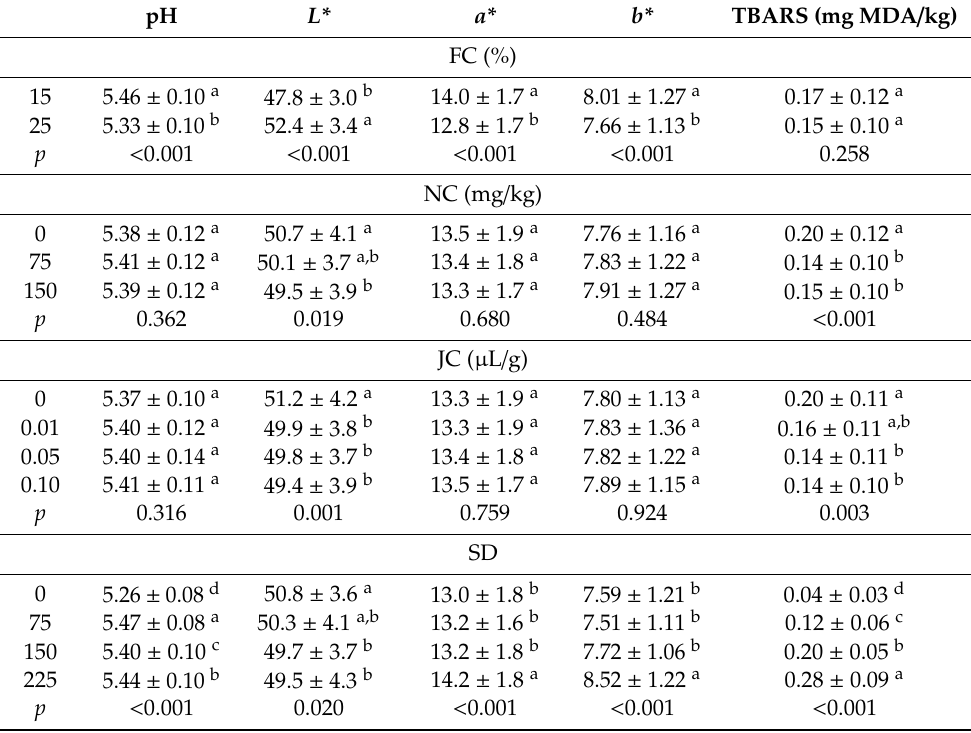
Table 2. pH, instrumental parameters of color and 2-Thiobarbituric acid reactive substances (TBARS) values of dry fermented